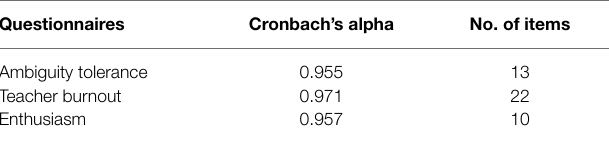
TABLE 1 | Reliability of the